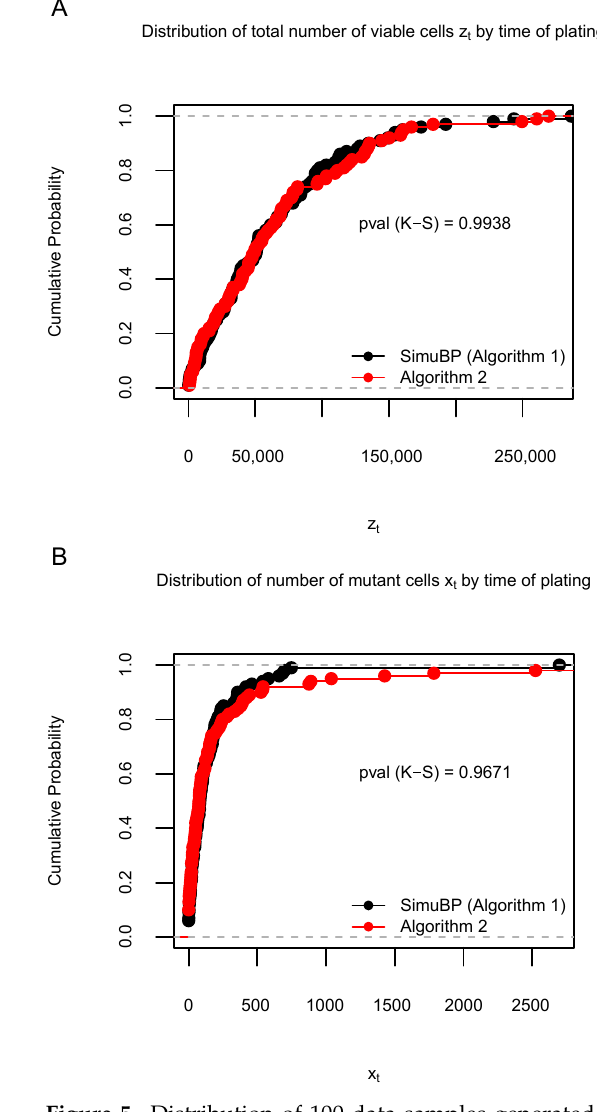
Figure 5. Distribution of 100 data samples generated by Algorithms 1 and 2 in Simulation S2a. ( A ): Empirical cumulative distribution function (ECDF) of the total number of viable cells z t when the time of plating t p = 11. ( B ): ECDF of the number of mutant cells x t when t p = 11. The Kolmogorov–Smirnov (K-S) test p -values are shown under the ECDF